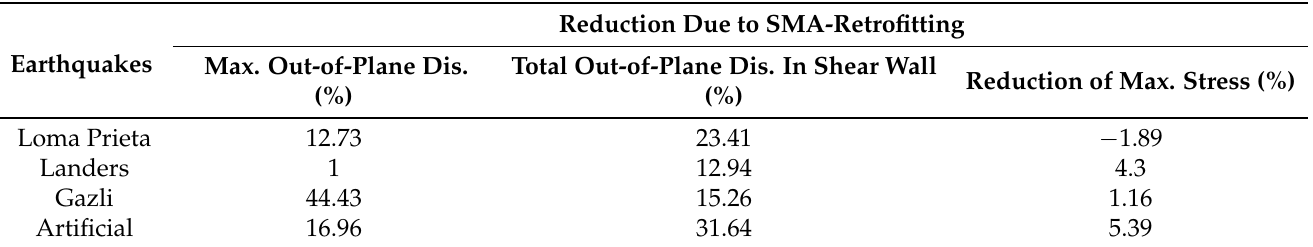
Table 5. The reduction percentage of the out-of-plane deformation in the SSW retrofitted with SMA [71]. Reduction Due to SMA-Retrofitting Earthquakes Max. Out-of-Plane